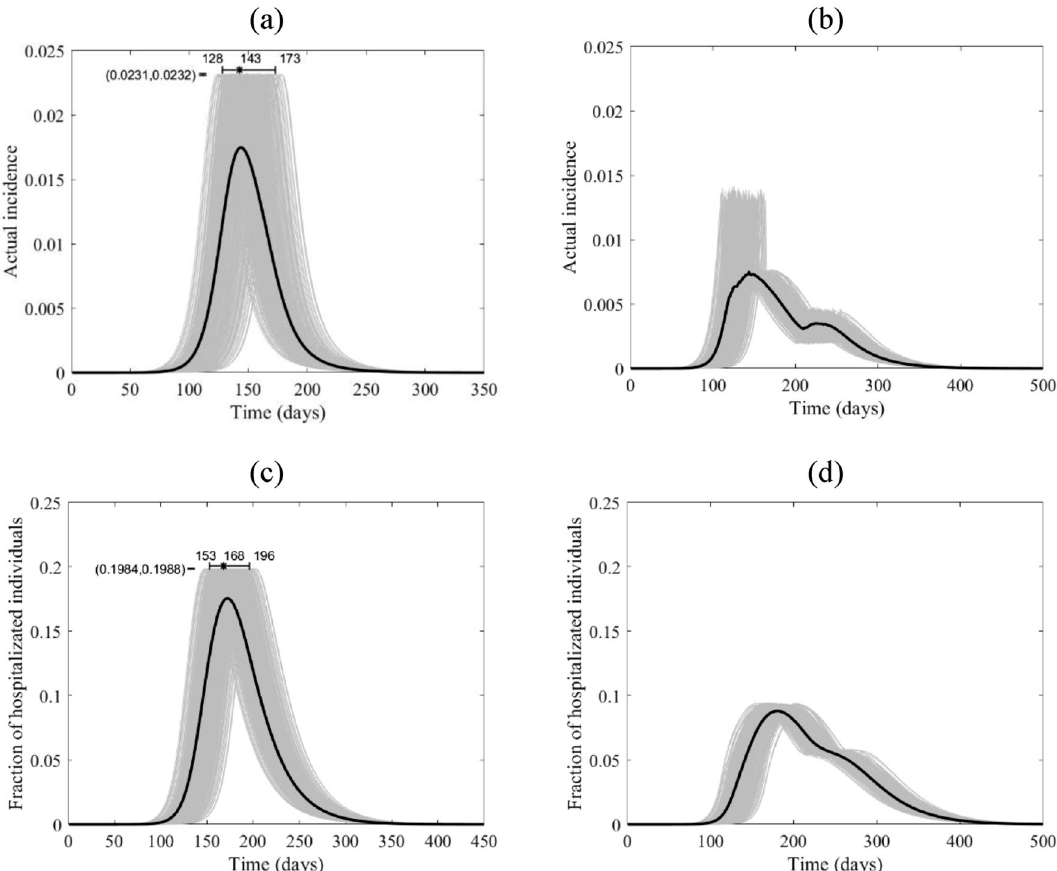
Figure 8. The course of the actual incidence of COVID-19 ( a ) and ( b ), and fraction of hospitalized infected individuals ( c ) and ( d ) in Niger with no control measure (left panel) and with starting lockdown (right panel) of 15 days before the peak and that lasts for 90 days. They are calculated at R 0 = 6.47 , with initially one adult mild infection. The grey curves are resulting from the stochastic model simulations and the black curve is the mean of those grey curves. They are all normalized by the population